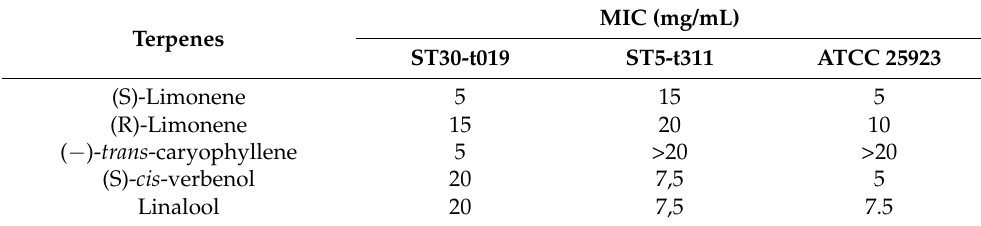
Table 1. Minimum inhibitory concentrations of